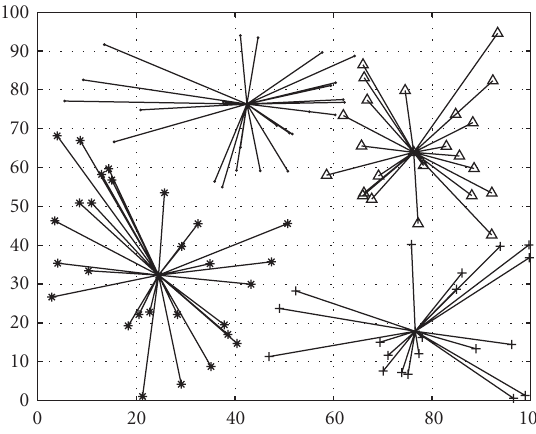
Figure 6: The clustering structure for using PCA-RA.